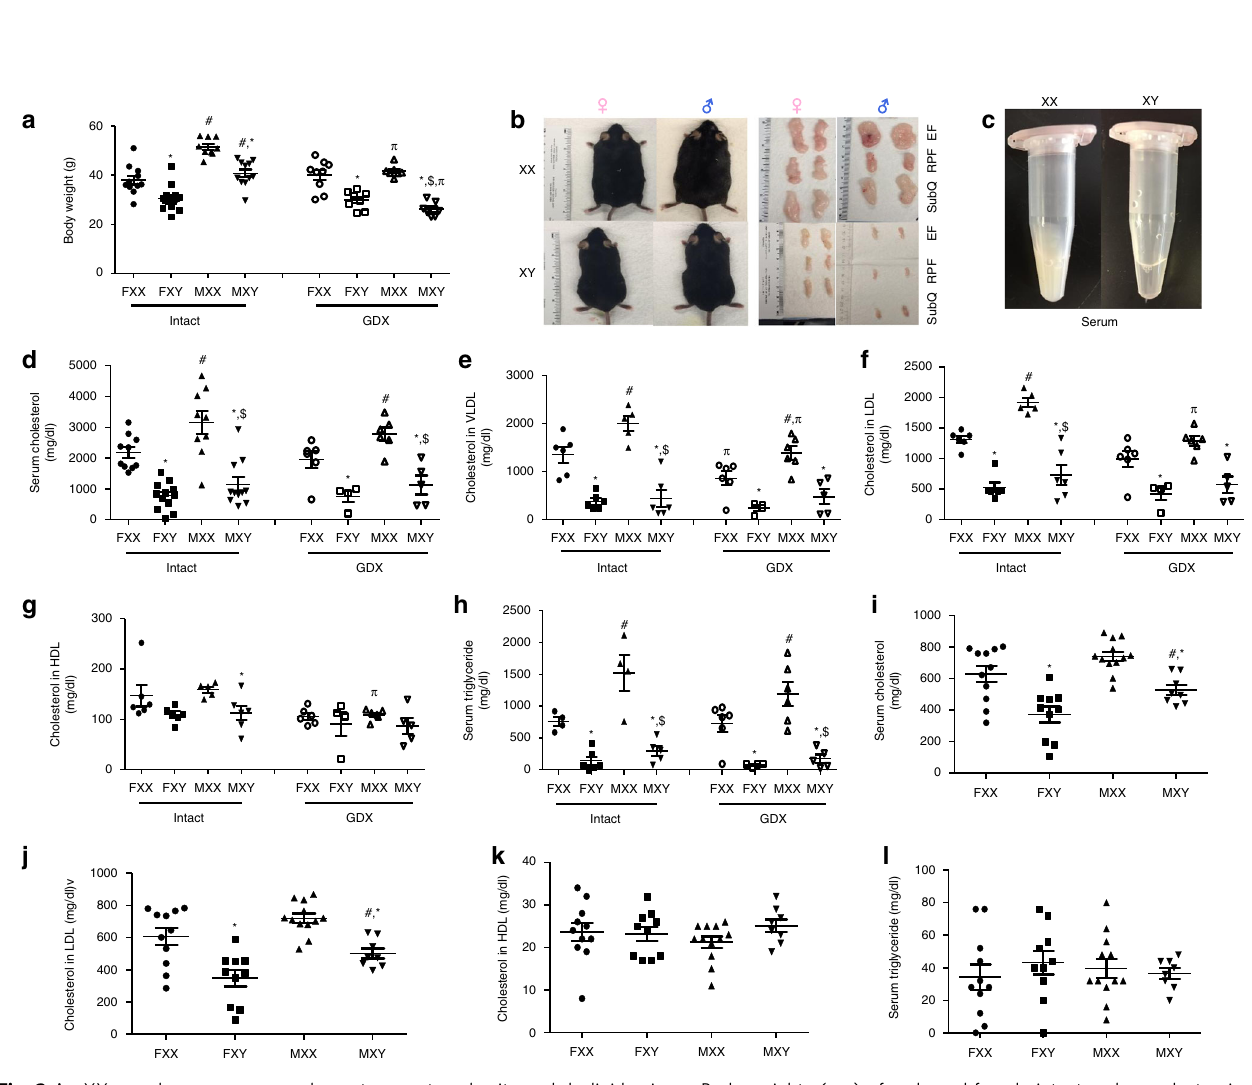
Fig. 2 An XX sex chromosome complement promotes obesity and dyslipidemias. a Body weights (gm) of male and female intact and gonadectomized (GDX) mice of each genotype (Intact: FXX, n = 11; FXY, n = 14; MXX, n = 9; MXY, n = 11; GDX: FXX, n = 9; FXY, n = 8; MXX, n = 7; MXY, n = 7). b Representative pictures of mice from each group (left), with adipose tissue depots illustrated. c Representative pictures of serum from XX and XY male mice. d Total serum cholesterol concentrations (Intact: FXX, n = 10; FXY, n = 12; MXX, n = 9; MXY, n = 11; GDX: FXX, n = 6; FXY, n = 4; MXX, n = 6; MXY, n = 5). Concentrations of very low density lipoprotein (VLDL)-cholesterol ( e ) (Intact: FXX, n = 6; FXY, n = 6; MXX, n = 5; MXY, n = 6; GDX: FXX, n = 6; FXY, n = 4; MXX, n = 6; MXY, n = 5), low density lipoprotein (LDL)-cholesterol ( f ) (Intact: FXX, n = 6; FXY, n = 6; MXX, n = 5; MXY, n = 6; GDX: FXX, n = 6; FXY, n = 4; MXX, n = 6; MXY, n = 5) and high density lipoprotein (HDL)-cholesterol ( g ) (Intact: FXX, n = 6; FXY, n = 4; MXX, n = 6; MXY, n = 5; GDX: FXX, n = 6; FXY, n = 4; MXX, n = 6; MXY, n = 5) and TG ( h ) (Intact: FXX, n = 4; FXY, n = 6; MXX, n = 4; MXY, n = 5; GDX: FXX, n = 6; FXY, n = 4; MXX, n = 6; MXY, n = 5) in Ldlr − / − mice fed a Western diet for 4 months. Concentrations of total serum cholesterol ( i ) (FXX, n = 11; FXY, n = 10; MXX, n = 12; MXY, n = 8), LDL-cholesterol ( j ) (FXX, n = 11; FXY, n = 10; MXX, n = 12; MXY, n = 8), HDL-cholesterol ( k ) (FXX, n = 11; FXY, n = 10; MXX, n = 12; MXY, n = 8) and TG ( l ) (FXX, n = 11; FXY, n = 10; MXX, n = 12; MXY, n = 8) in Apoe − / − mice fed a standard murine diet. Symbols represent individual mice per group per measurement, with horizontal lines representing mean ± SEM. * P < 0.05 compared to XX within gonadal sex. # P < 0.05 compared to female within sex chromosome complement. $ P < 0.05 compared to XX females. Data were analyzed by 3-way ANOVA ( a , d – h ) with Holm – Sidak test, or by 2-way ANOVA ( i – l ) with Holm – Sidak test. Source data are available as a Source Data fi le. RPF retroperitoneal, EF epididymal, SubQ